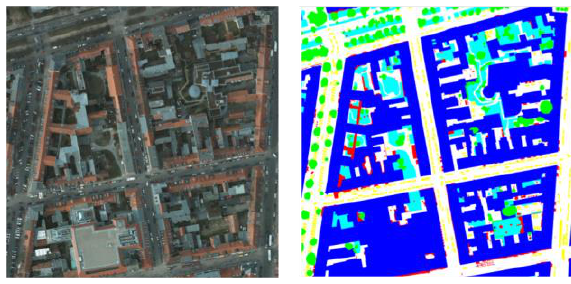
Figure 7. Image and ground truth sample